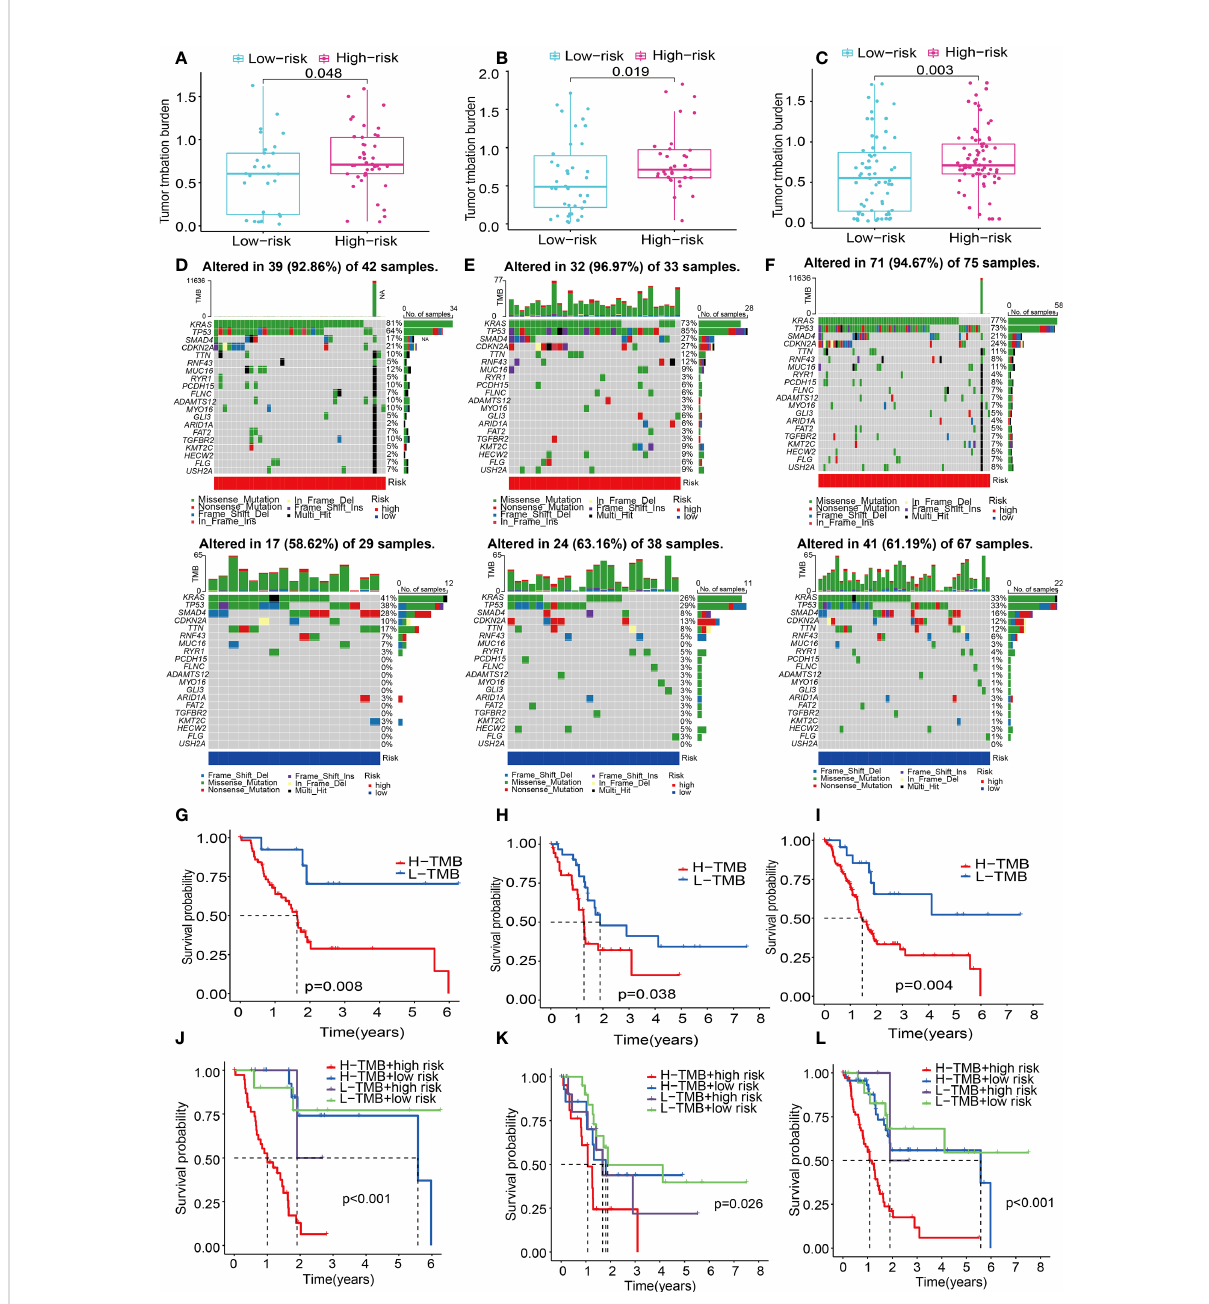
FIGURE 12 ECM-APP-based analysis of tumor mutation pro fi les and their clinical correlation. (A – C) The discrepancy in the TMB scores between low-risk and high-risk subgroups in the train, test1, and test2 cohorts. (D – F) The waterfall plot showed the frequently mutated genes in low-risk and high-risk groupings from the train, test1, and test2 cohorts. High risk is indicated by the red line, while low risk is denoted by the blue line. (G – I) Survival analysis of TMB scores in low- and high-risk subgroups from the train, test1, and test2 cohorts. (J – L) Survival analysis strati fi ed by the risk scores and TMB scores from the train, test1, and test2